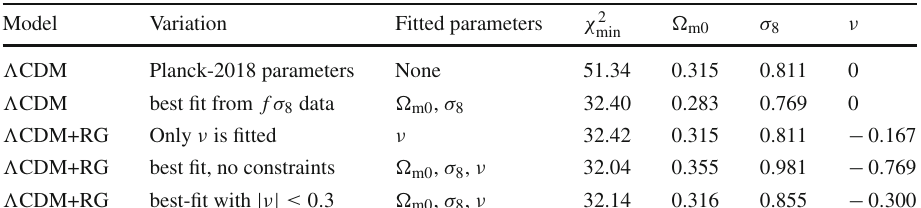
Table 1 Best-fit results for f σ 8